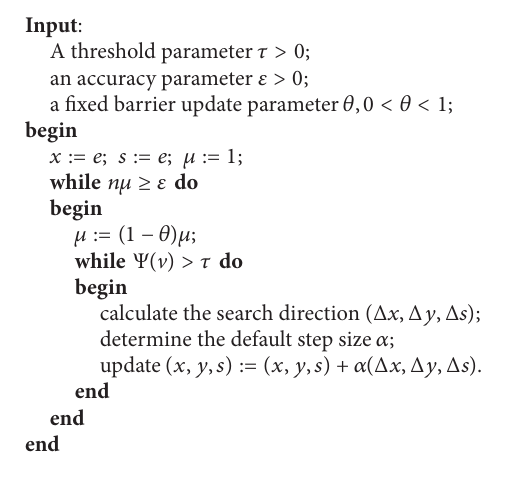
Algorithm 1: Generic primal-dual interior-point algorithm for